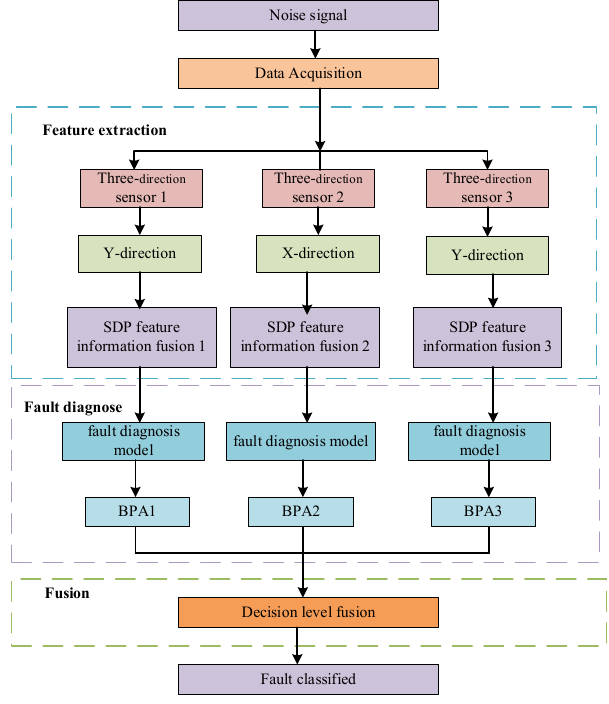
Figure 8. Fault diagnosis framework based on single-channel gear pitting level.